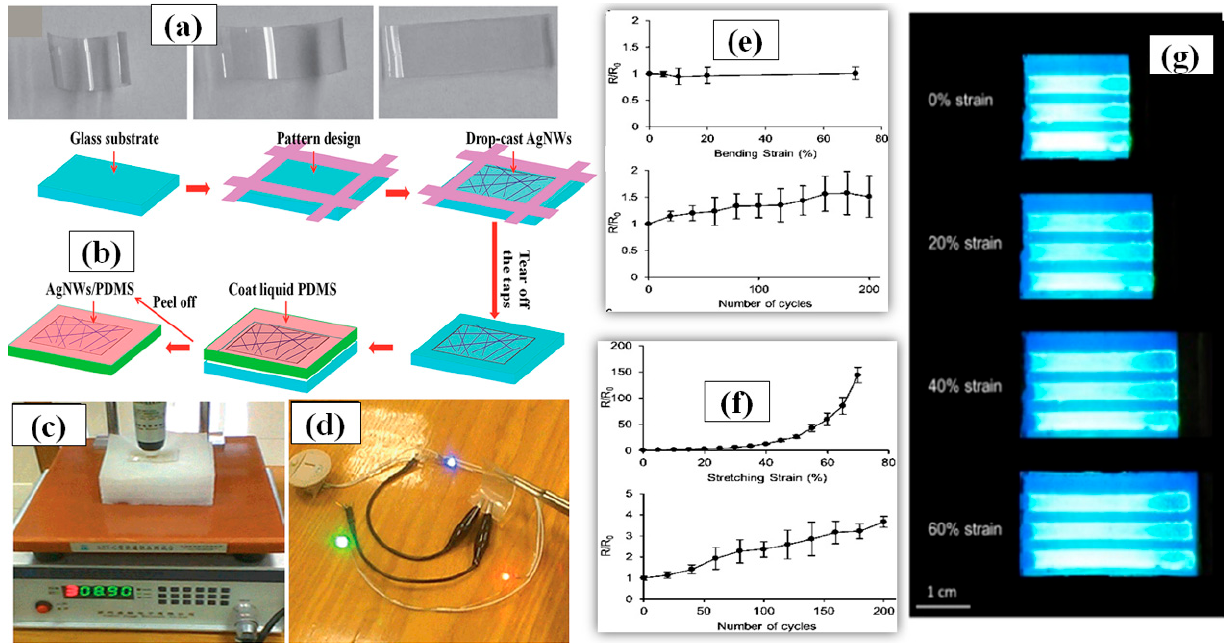
Figure 10. ( a ) illustrating the shape memory property of an AgNW/polymer electrode: photographs of a highly curved AgNW/polymer electrode (left) and its steady relaxation at 120 °C to an intermediate (center) and recovered shape after some time (right). (adapted from [160] with permission from John and Wiley sons, 2011) ( b ) A schematic procedure for AgNW/PDMS electrode fabrication by drop casting, ( c ) sheet resistance of the transparent electrodes (T = 81%) measured using a four-point probe instrument; ( d ) flexible transparent conductive film (T = 90%) in an electrical circuit powering three LEDs. (adapted from [161] with permission from Royal Society of Chemistry, 2014)) ∆ R/R versus ( e ) bending strain and ( f ) stretching strain of fabricated electrode ( g ) real time device testing with no decay up to 60% stretching (adapted from [162] with permission from ACS publications, 2019).